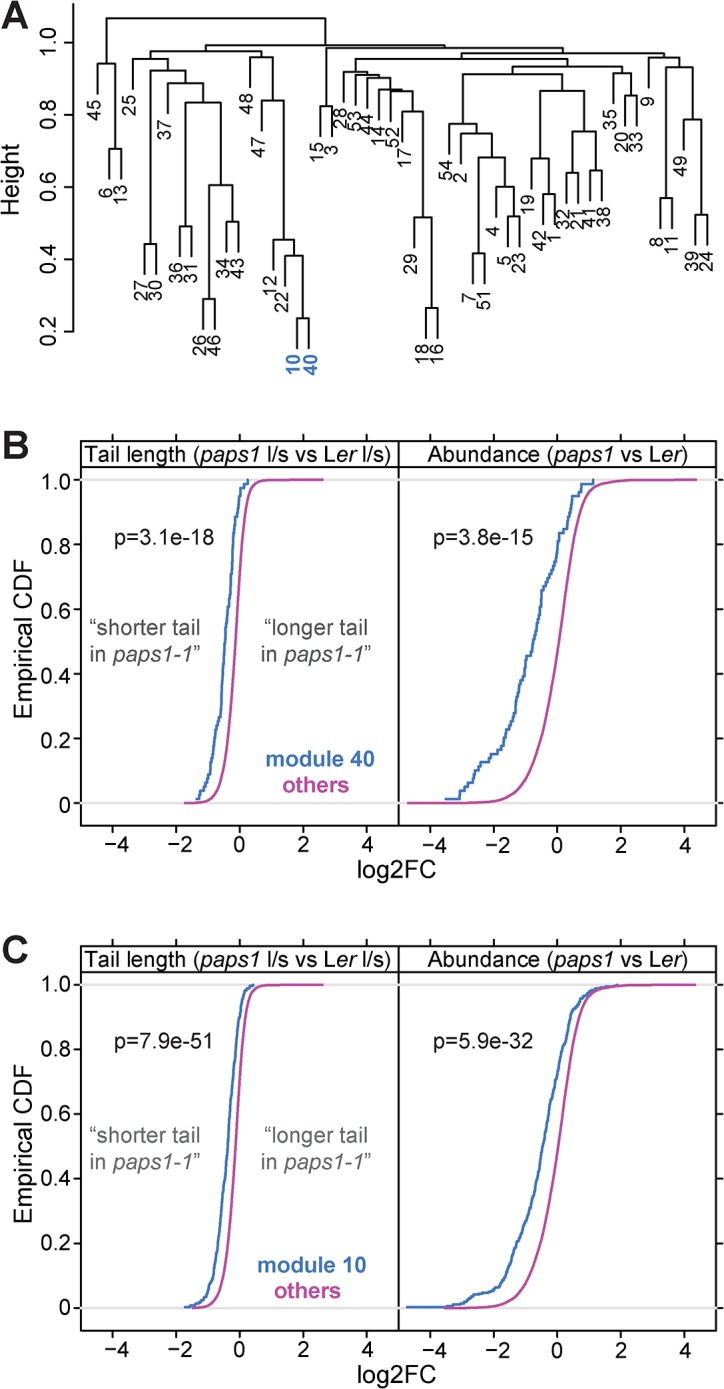
Genes coexpressed with PAPS1 are strongly affected in paps1 mutants.(A) Clustering analysis of coregulated modules across publicly available microarray data. PAPS1 is part of module 10. Modules 10 and 40 are highlighted. (B,C) Empirical cumulative distribution functions (CDF) of tail-length change (left) and mRNA abundance change (right) in paps1-1 versus wild type for genes in coregulated modules 10 (B) and 40 (C) compared to all other transcripts not in the respective module (other). p-values are from Wilcoxon rank-sum tests. Negative log2FC means shorter tail and reduced abundance in paps1 mutants compared to wild type, respectively.